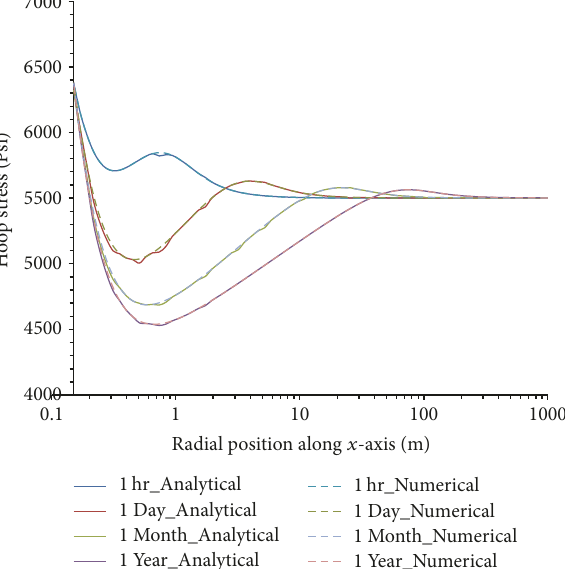
Figure 4: 𝑋 -displacement along 𝑥 -axis as a function of time in poroelastic medium with 𝜎 𝐻 = 5800 psi and 𝜎 ℎ = 5500 psi, 𝑃 𝑟 = 5500 psi, 𝑃 𝑤 = 1000 psi, 𝑘 𝑥 = 0.01 md, and 𝑘 𝑦 = 0.01 md.